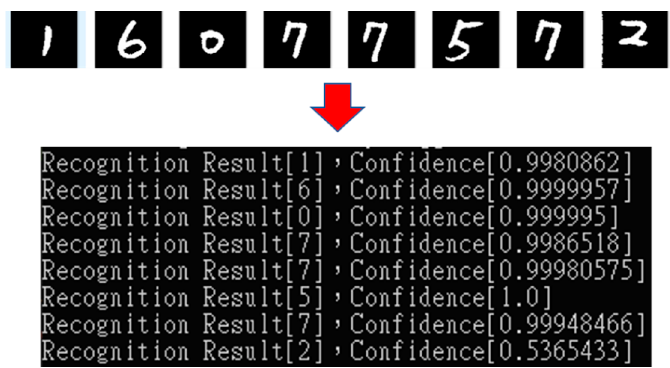
Figure 18. CNN recognition results .